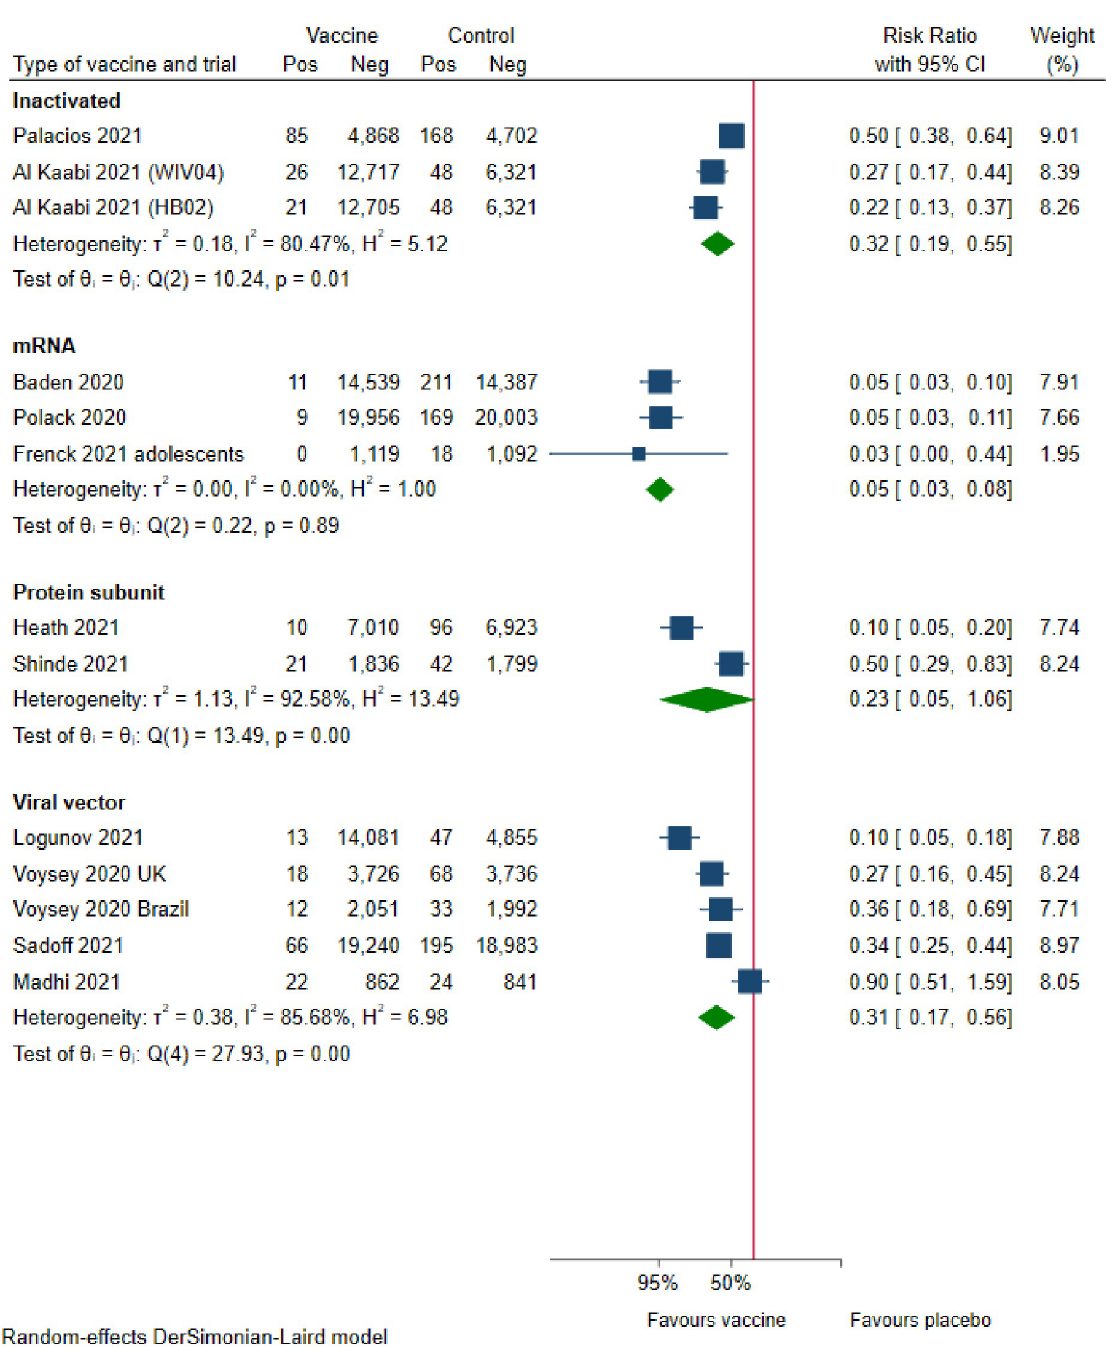
Fig 4. COVID-19 vaccine efficacy on preventing symptomatic COVID-19 participants with positive